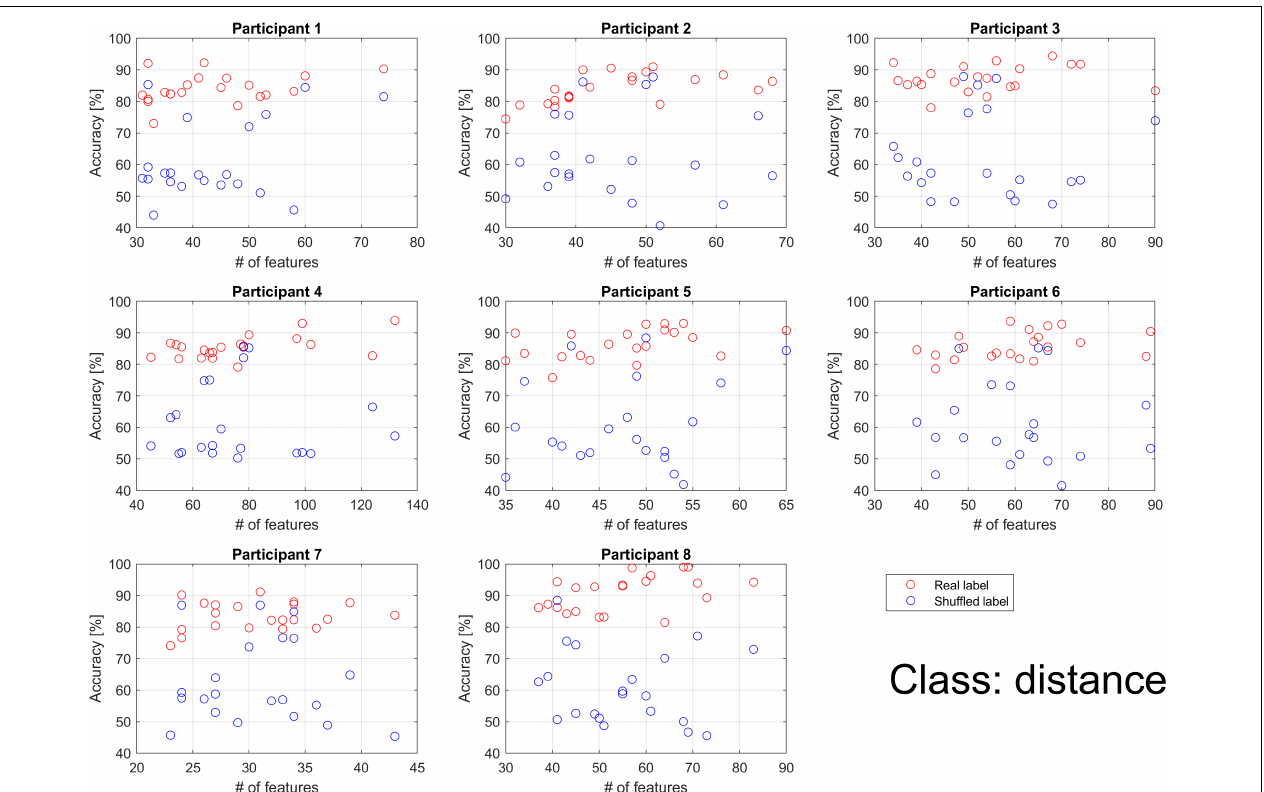
FIGURE 6 | Individual classification accuracies for distance according to the number of features. Each dot represents the accuracy for each binary classification. The binary classifications were performed 21 times (7 choose 2) per participant when the feature for all classifications had at least 1. Blue circles represent the result when shuffled labels were used. Red circles represent the result when real labels were used. Performance for the real label increased in proportion to the number of features, while performance for the shuffled label did not depend on the number of features.